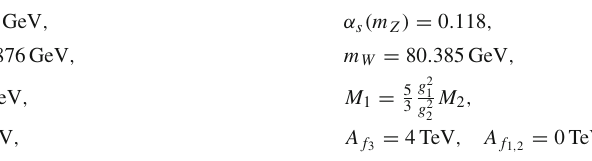
carry the generation g